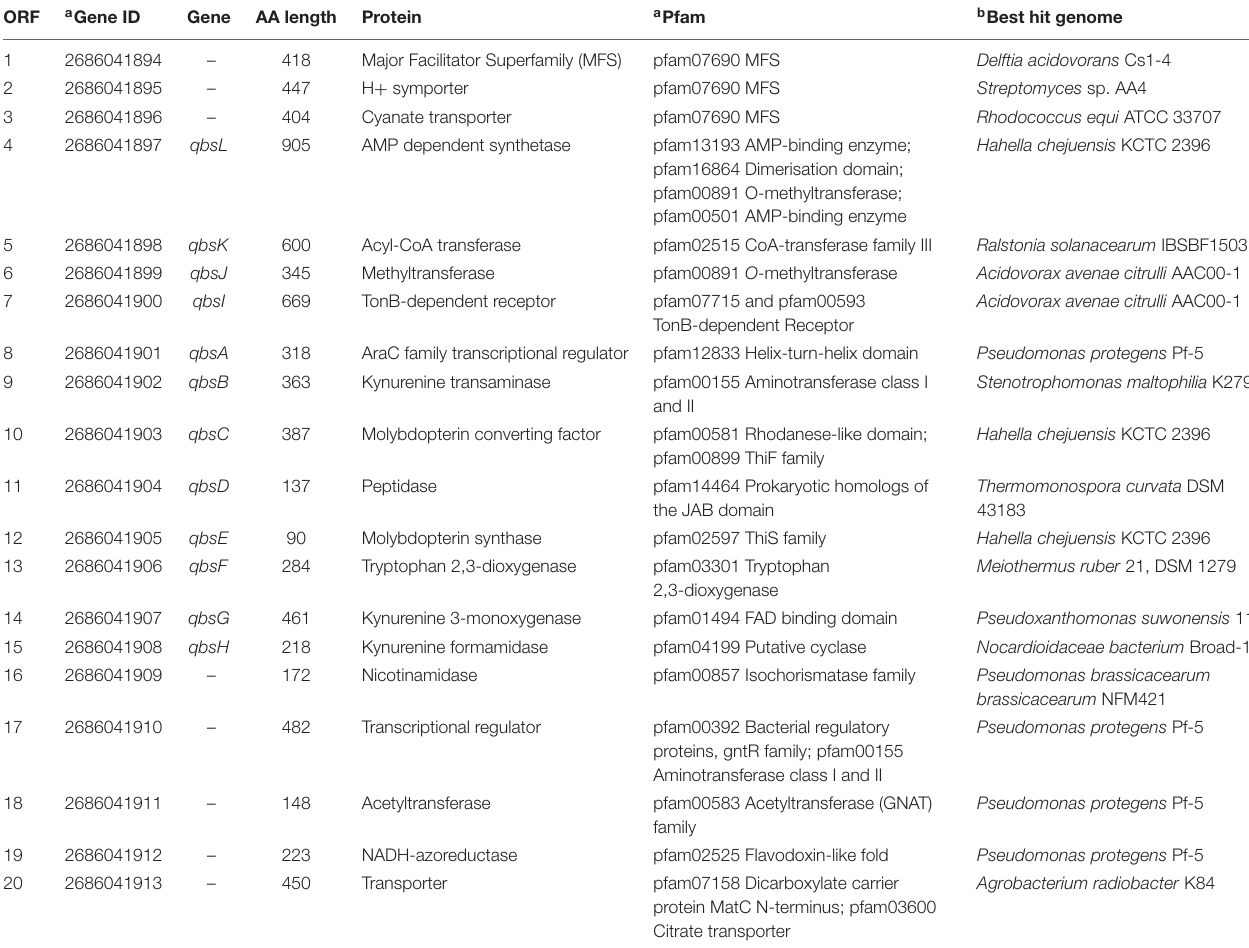
TABLE 2 | Strain 06C 126 qbs gene